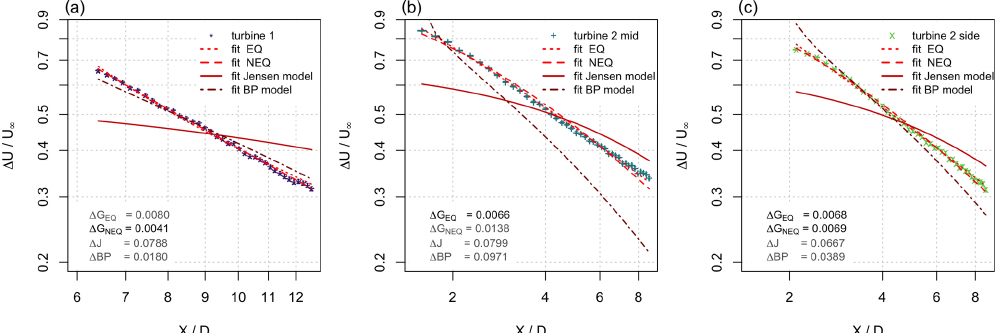
Figure 9. (cid:49)U/U ∞ for three different inflow conditions: (a) turbine 1 – laminar inflow, (b) turbine 2 mid – turbulent, and (c) turbine 2 side – turbulent and intermittent. Error bars are included but very small. Different models are fitted to the recovery region, and the residual standard errors are presented. Note that the axes are